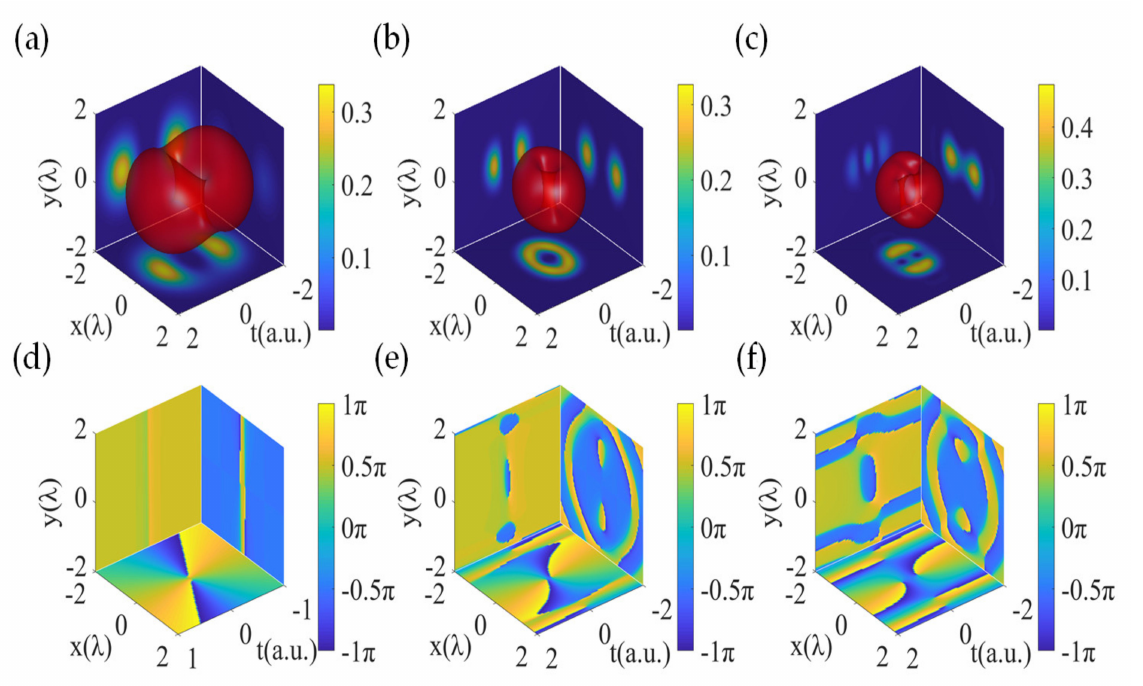
Figure 4. The intensity and phase distributions of the y-polarized components of the focused STOVs under different incident spatial waist radii. ( a – c ) The intensity distributions of the y-polarized components of the focused STOVs corresponding to incident spatial waist radii of 0.3, 0.5, and 0.7, respectively. ( d – f ) The phase distributions corresponding to the three cases, respectively. The isosurfaces are depicted at 5% of the maximum intensity in each